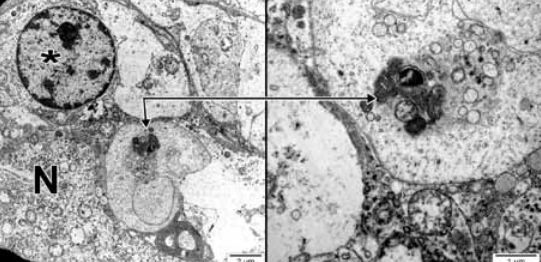
Figure 4. Ultrathin cut of human adult trigeminal ganglion. Left panel: general view, partly depicting a trigeminal neuron (N), a differentiated SGC (*), and a partly differentiated SGC (connector, detailed in the right